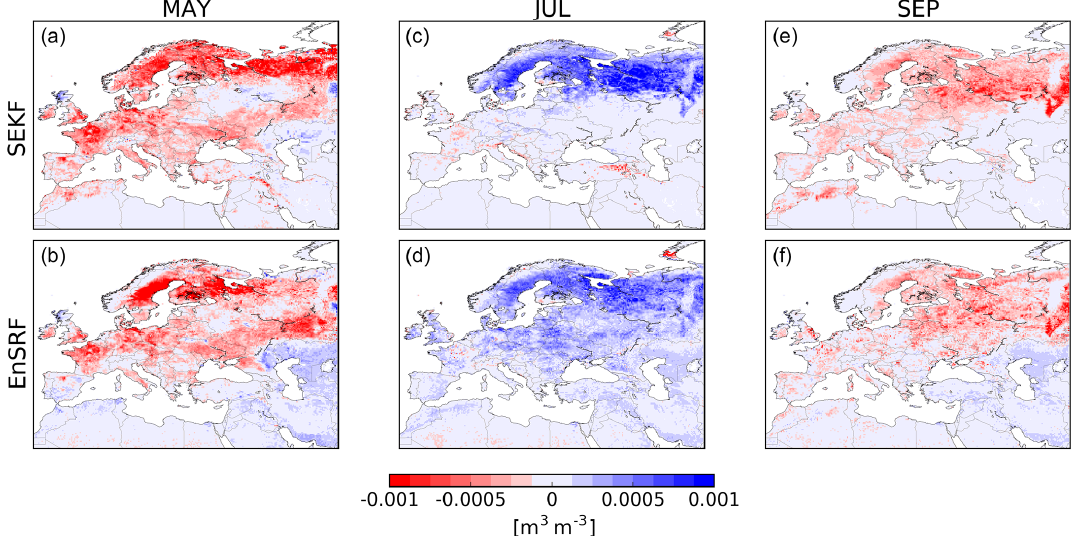
Figure 11. Averaged analysis increments for soil moisture in the fourth layer (10–20cm; SM4) for SEKF and EnSRF for the months of May (a, b) , July (c, d) and September (e, f)